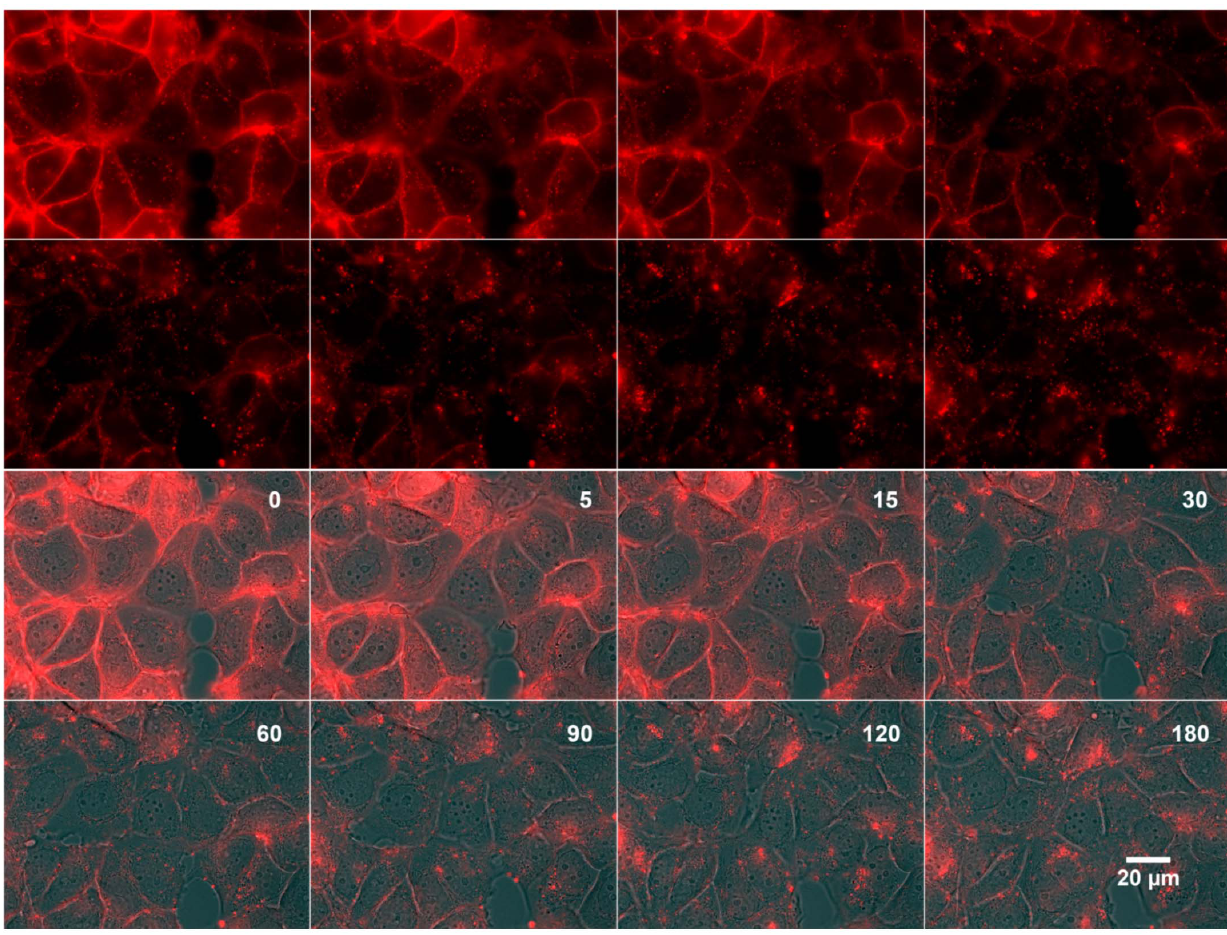
Figure 6. Time-lapse imaging over 3 hours of the ACE4 aptamer internalization in MCF7 cells. The fluorescently labeled ACE4 aptamer was incubated with MCF-7 cells before washing and fluorescent time-lapse imaging. The first two rows display the red fluorescent channel only. The two second ones are a merge of the corresponding fluorescent and brightfield channels. The elapsed time is expressed in minutes and recorded on each merged image only.